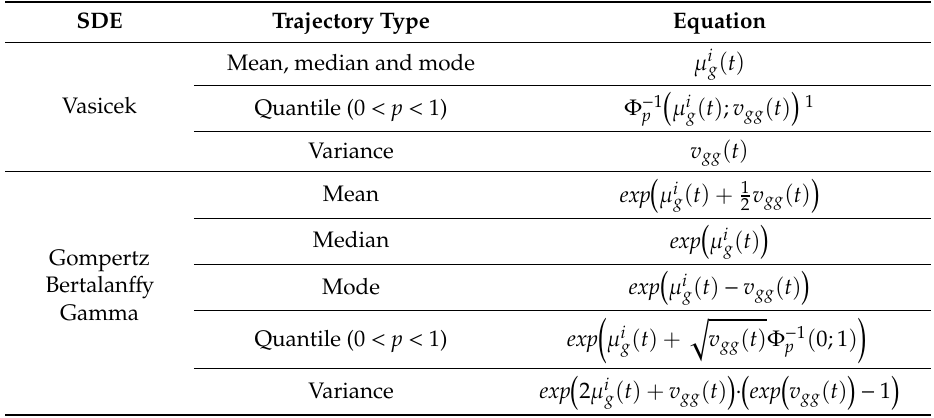
Table 2. Marginal mean, median, mode, p -quantile (0 < p < 1), and variance trajectories. SDE